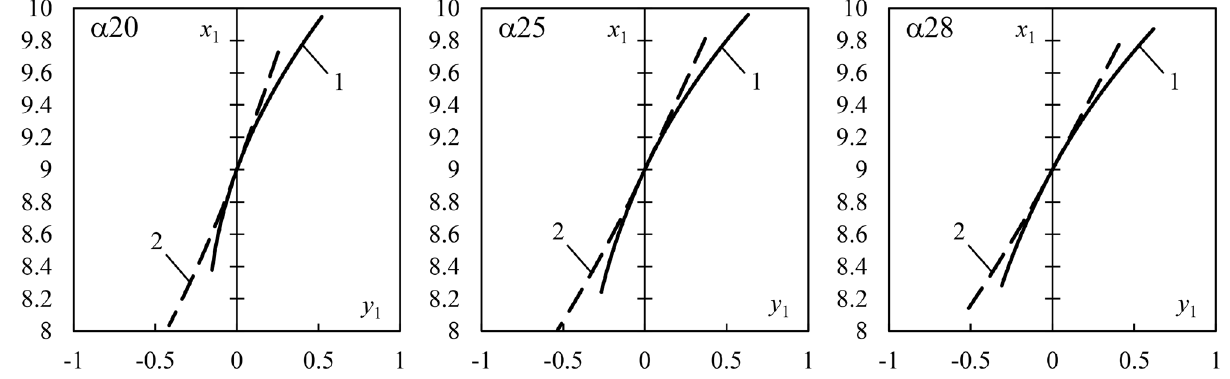
Fig. 2. Geometry of the teeth active pro fi les of the pinion 1 and gear